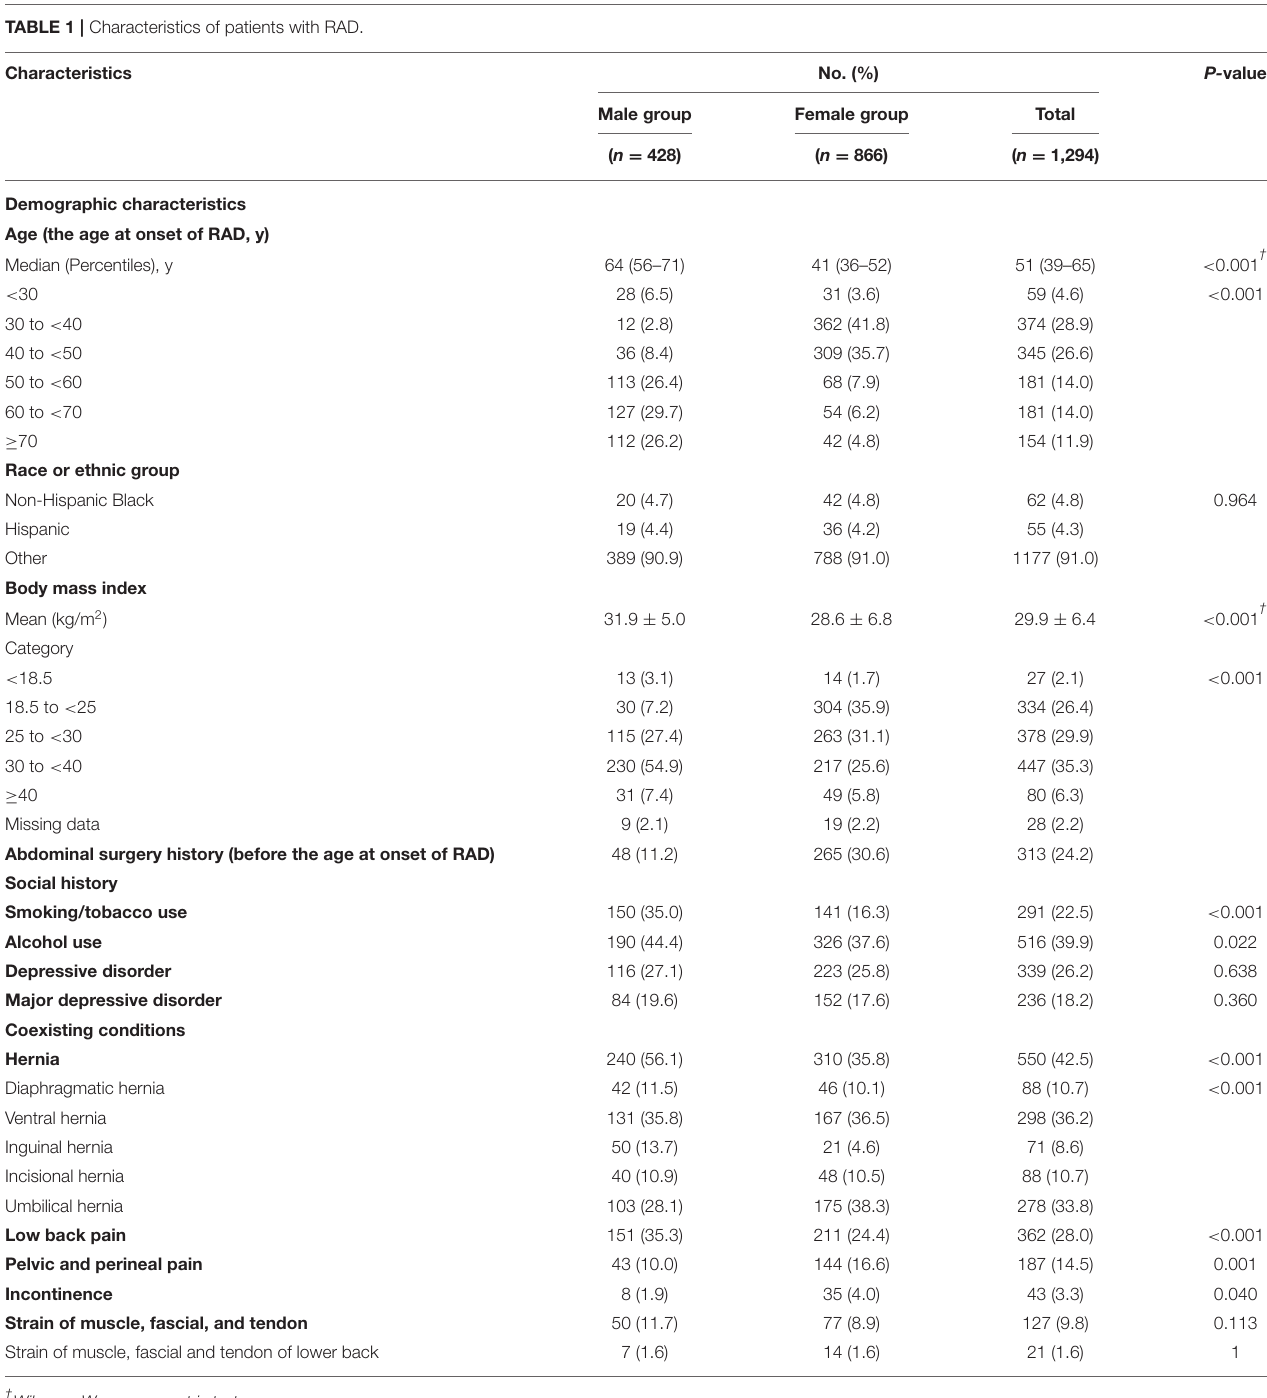
TABLE 1 | Characteristics of patients with